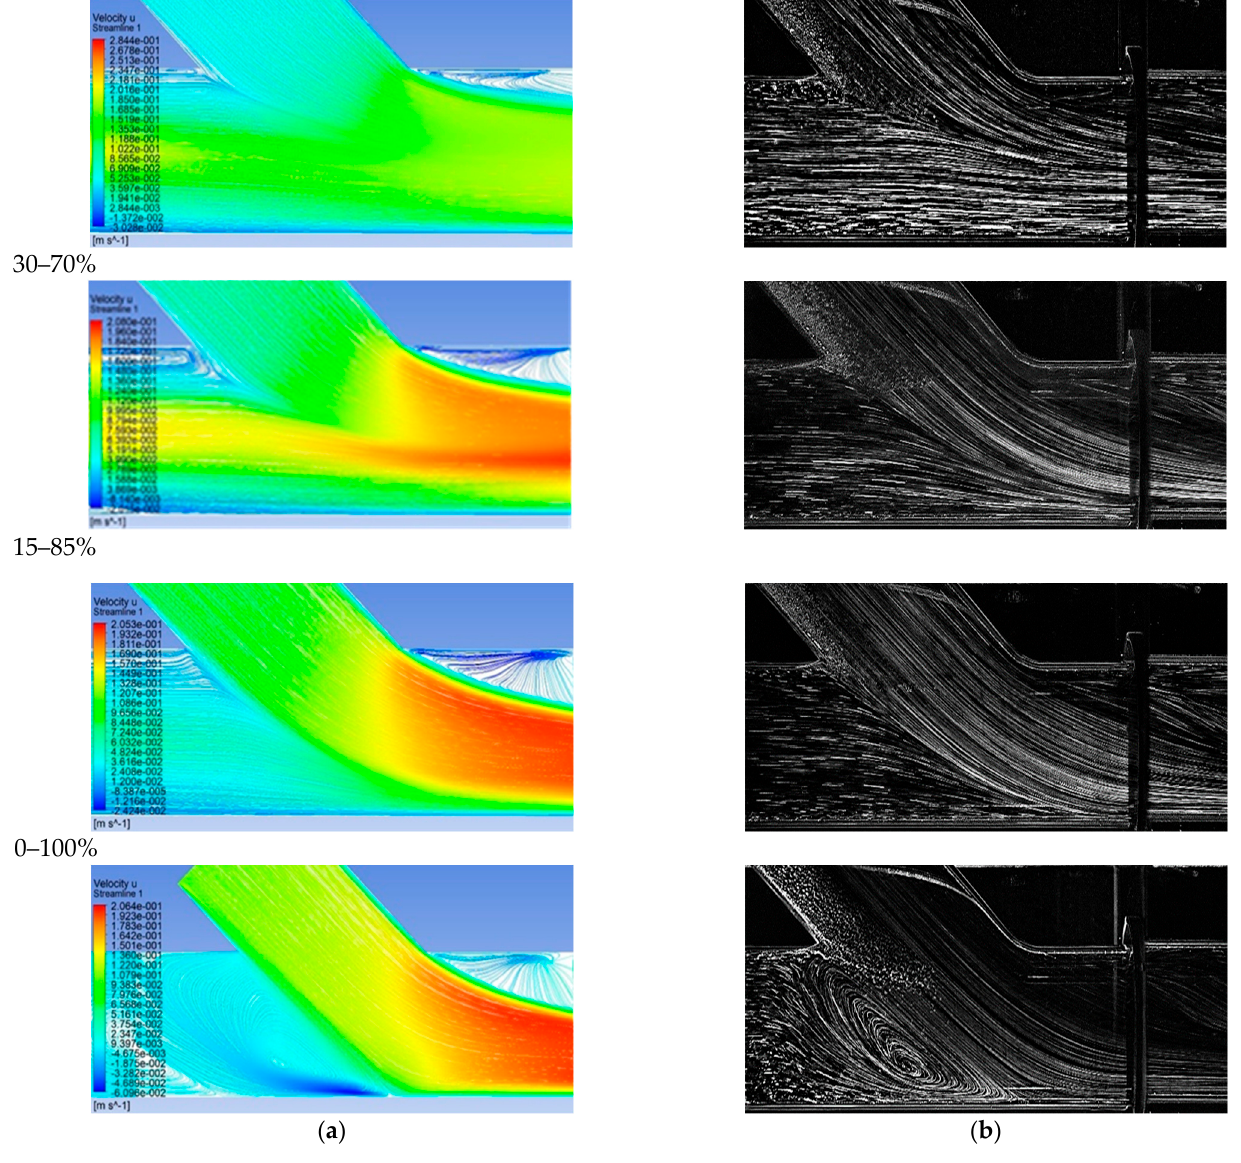
Figure 10. Comparison between computational and experimental visualization results in the anas- tomosis region ( a ) Computational results of the longitudinal velocity component, ( b ) experimental visualization results.